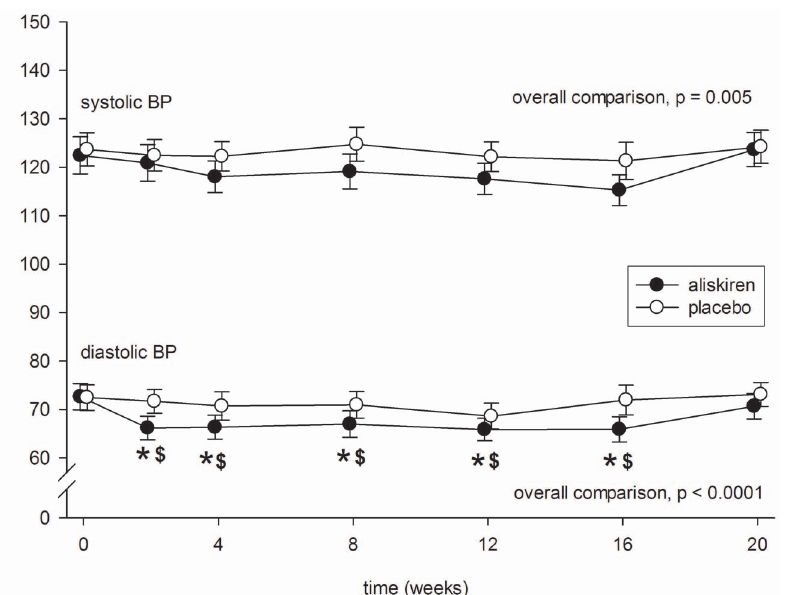
Figure 4. Serial change in systolic and diastolic blood pressure (BP) during the periods of aliskiren (closed circles) and placebo (open circles) treatment. Error bars denote standard error of mean. Post-hoc comparisons were performed by paired Student’s t test: *p , 0.0001 as compared to baseline level; $ p , 0.05 as compared to the period of placebo treatment. All P values were computed with Bonferroni adjustment for multiple comparisons.